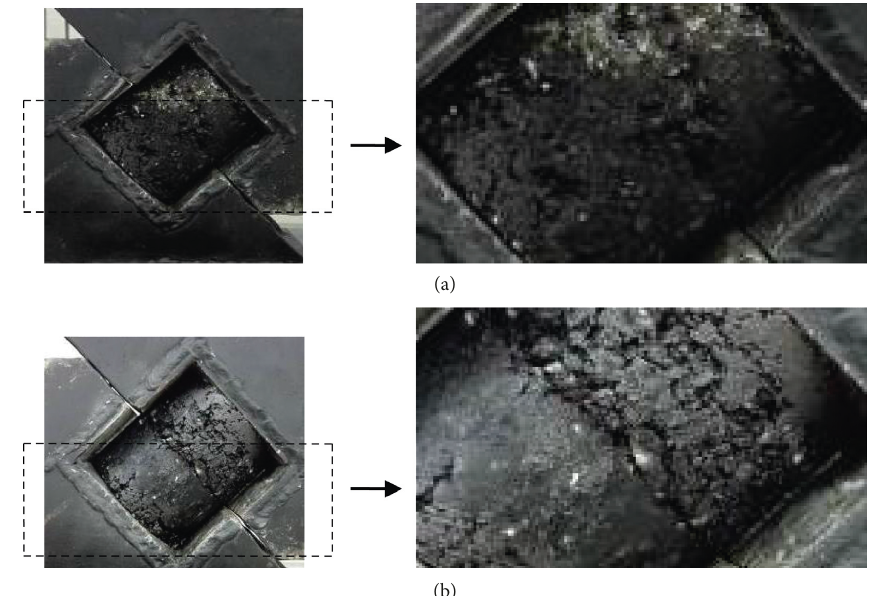
Figure 16: Comparison of test results from modes of specimen damage. (a) Continuous paving. (b) Discontinuous